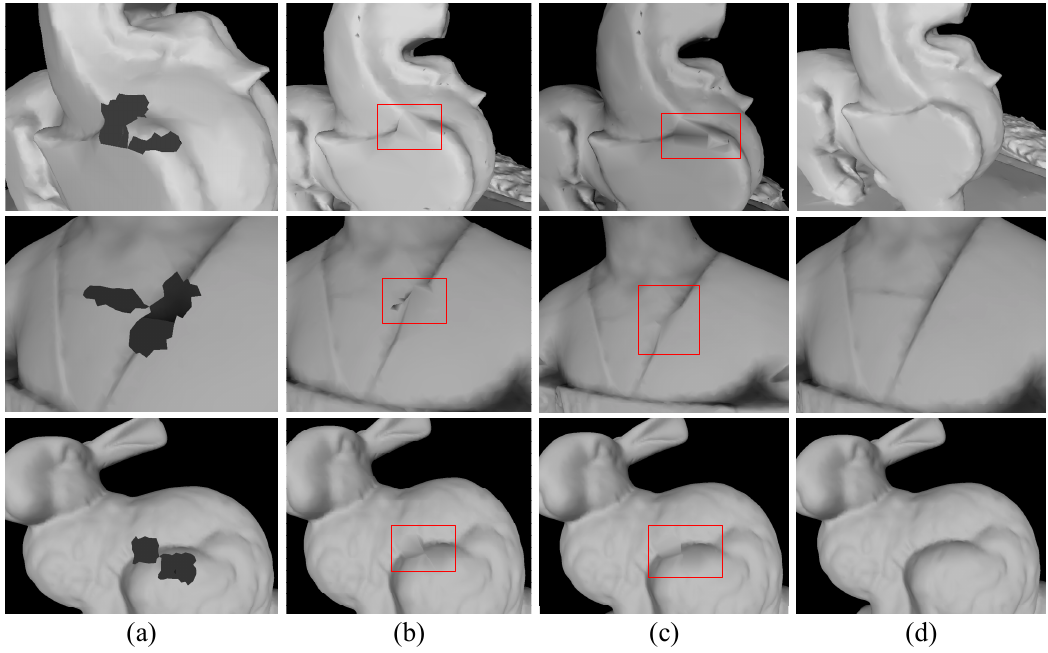
Figure 10. The holes filling results of the complex holes: (a) shows three are the raw models with holes, column (b) is the hole filling results of VCG, column (c) is the hole filling results of MeshFix, holes, column ( b ) is the hole filling results of VCG, column ( c ) is the hole filling results of MeshFix, and column (b) is the hole filling results of LIMOFilling. and column ( d ) is the hole filling results of